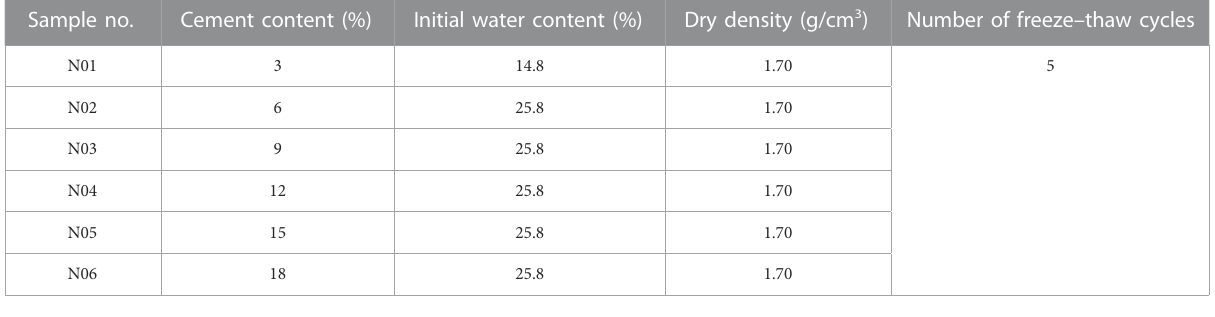
TABLE 3 Mixture proportions of cement-stabilized soil samples (%). Sample no.